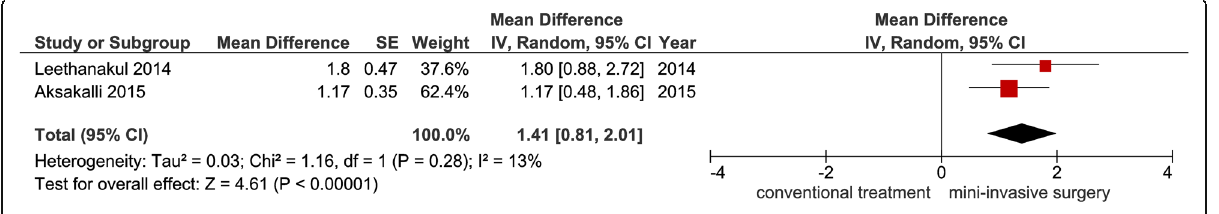
Fig. 5 Forest plot of the comparison between minimally invasive surgical procedures and conventional treatment for the canine retraction amount at 2